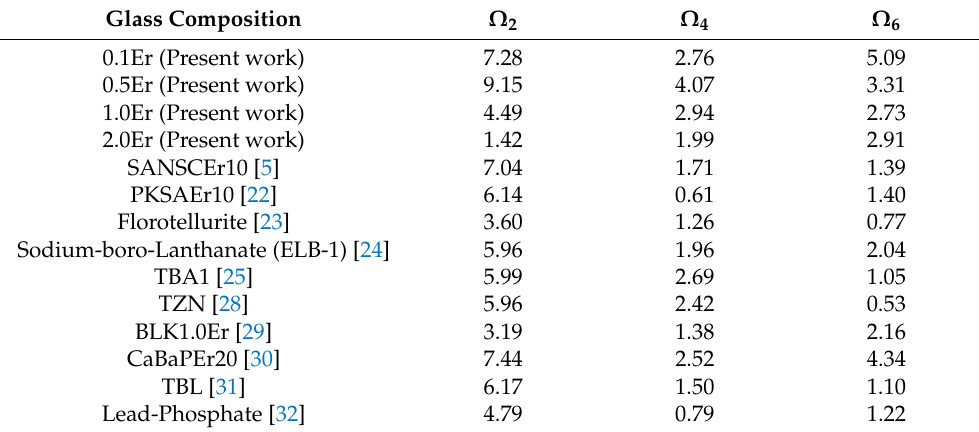
Table 3. The comparison of Judd-Ofelt parameters Ω λ ( λ = 2, 4 and 6 × 10 − 20 cm 2 ) of Er 3+ ions in different glass